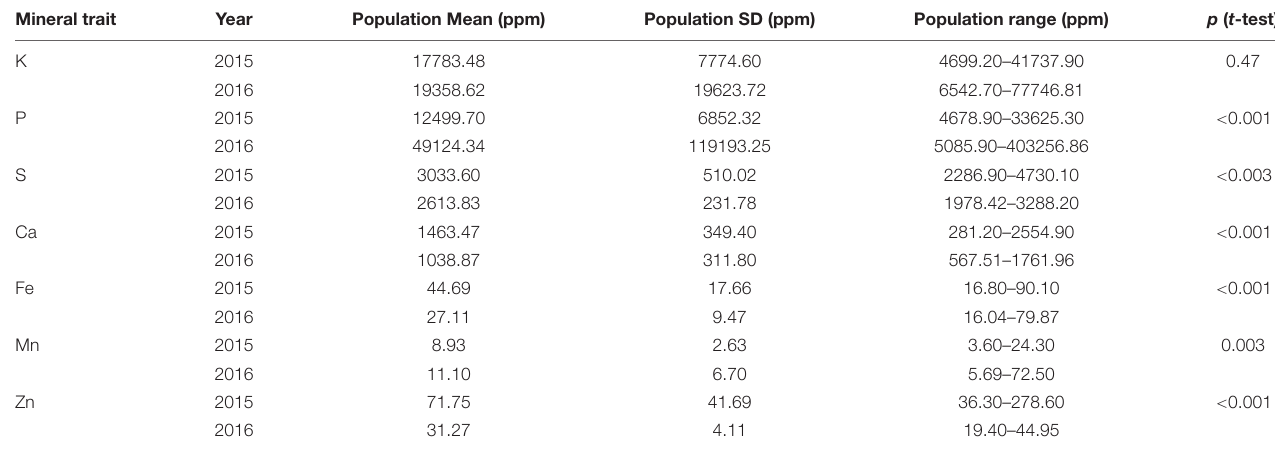
TABLE 1 | Descriptive statistics and t -test comparison for seed mineral concentrations in parts per million (ppm) analyzed in the entire USDA core collection and high yielding selection of mung bean genotypes planted in 2015 ( n = 408) and 2016 ( n = 95), respectively. Mineral trait